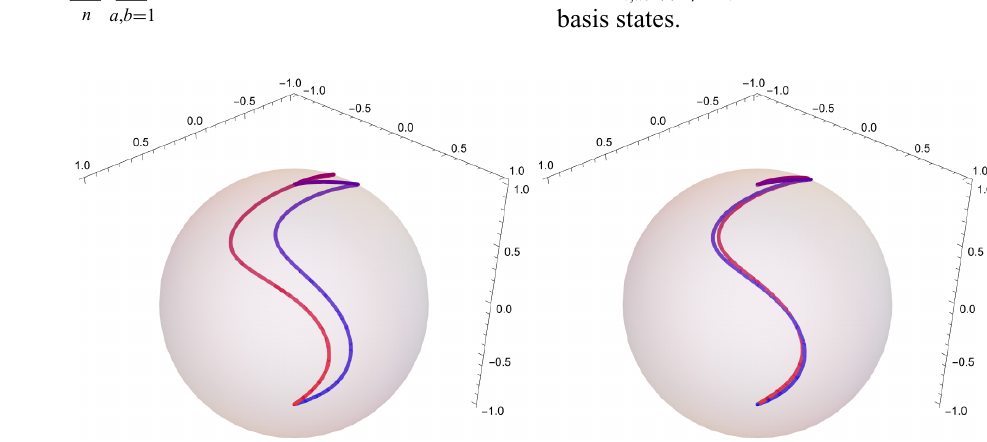
FIG. 6. An illustration of a dynamical invariant eigenvector’s evolution along the Bloch sphere for the geometric T gate (left) and the dynamical T gate (right). The path orientation is determined by the color gradient that begins with red and ends with blue. Just like in the previous example, we find that | φ + ( t ) (cid:2) traces out a loop with nonzero area in the geometric case and zero area in the dynamical